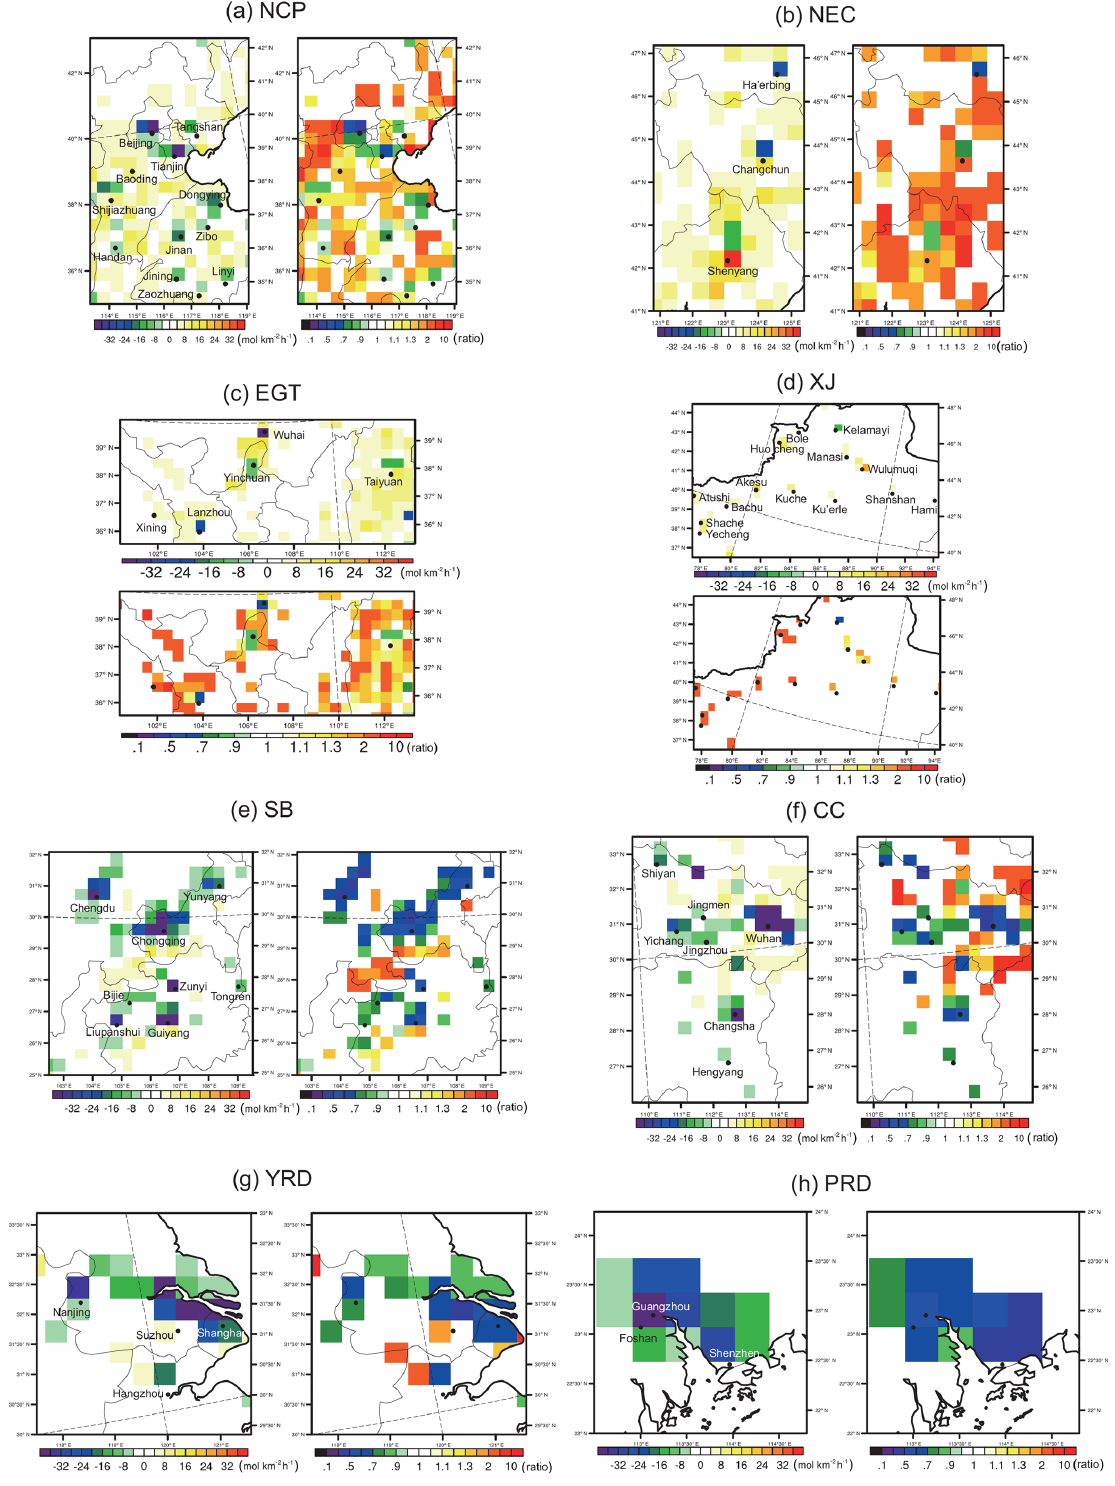
Figure 8. The differences between the analyzed 2015 January emissions and the 2010 a priori emissions in eight regions. Left/top panels are emission differences of 2015 − 2010 (units: molkm − 2 h − 1 ), and right/bottom panels are the ratios of 2015 / 2010 in each